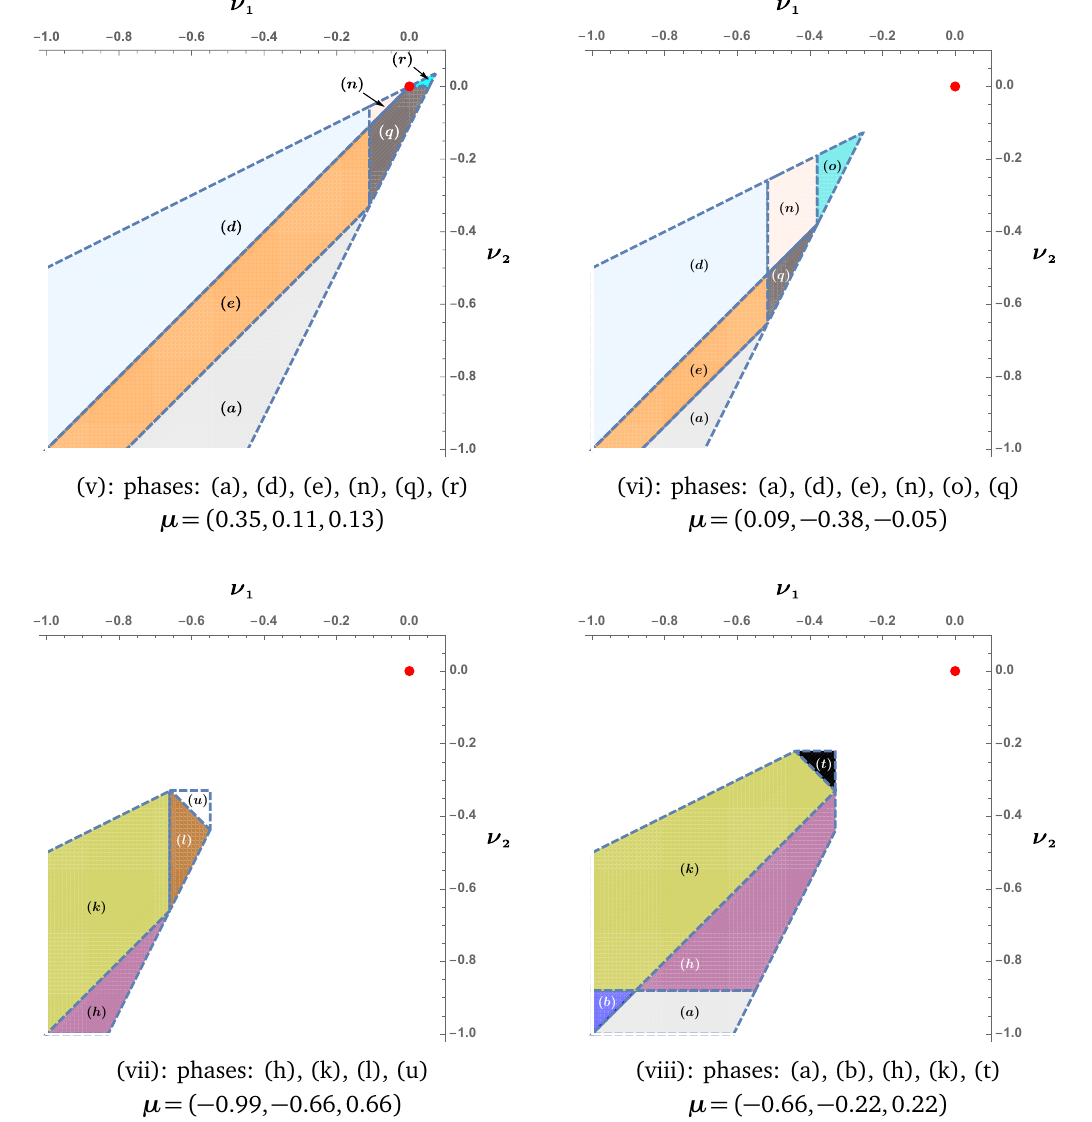
µ = ( − 0.66, − 0.22,0.22 )